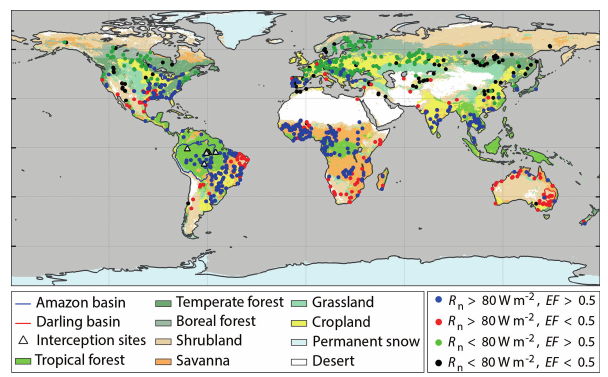
Figure 1. Climatic regimes and biomes considered in the eval- uations. The background map illustrates the land use classi- fication scheme of the International Geosphere–Biosphere Pro- gramme (IGBP) used in Fig. 8. The Darling Basin in southeast- ern Australia, as considered in Sect. 3.2, is contoured in red. The Amazon Basin, as considered in Sect. 3.4, is marked in blue, with white triangles indicating the locations of past interception loss campaigns. Dots indicate the centroids of the 837 basins used in the analyses presented in Sect. 3.3.